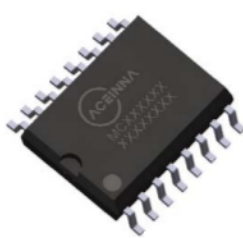
Figure 5. MCR 1101-20-5 package.